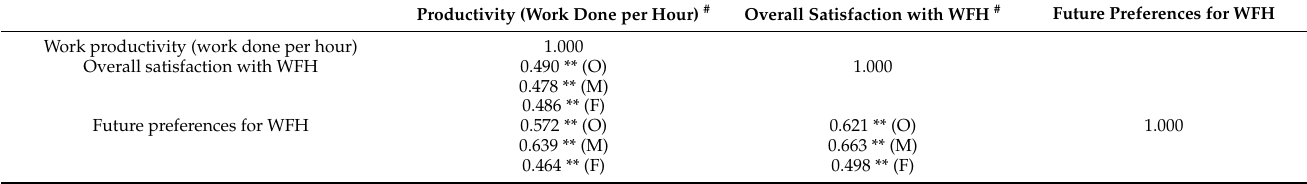
Table 7. Correlations between productivity, overall WFH satisfaction and future preference for